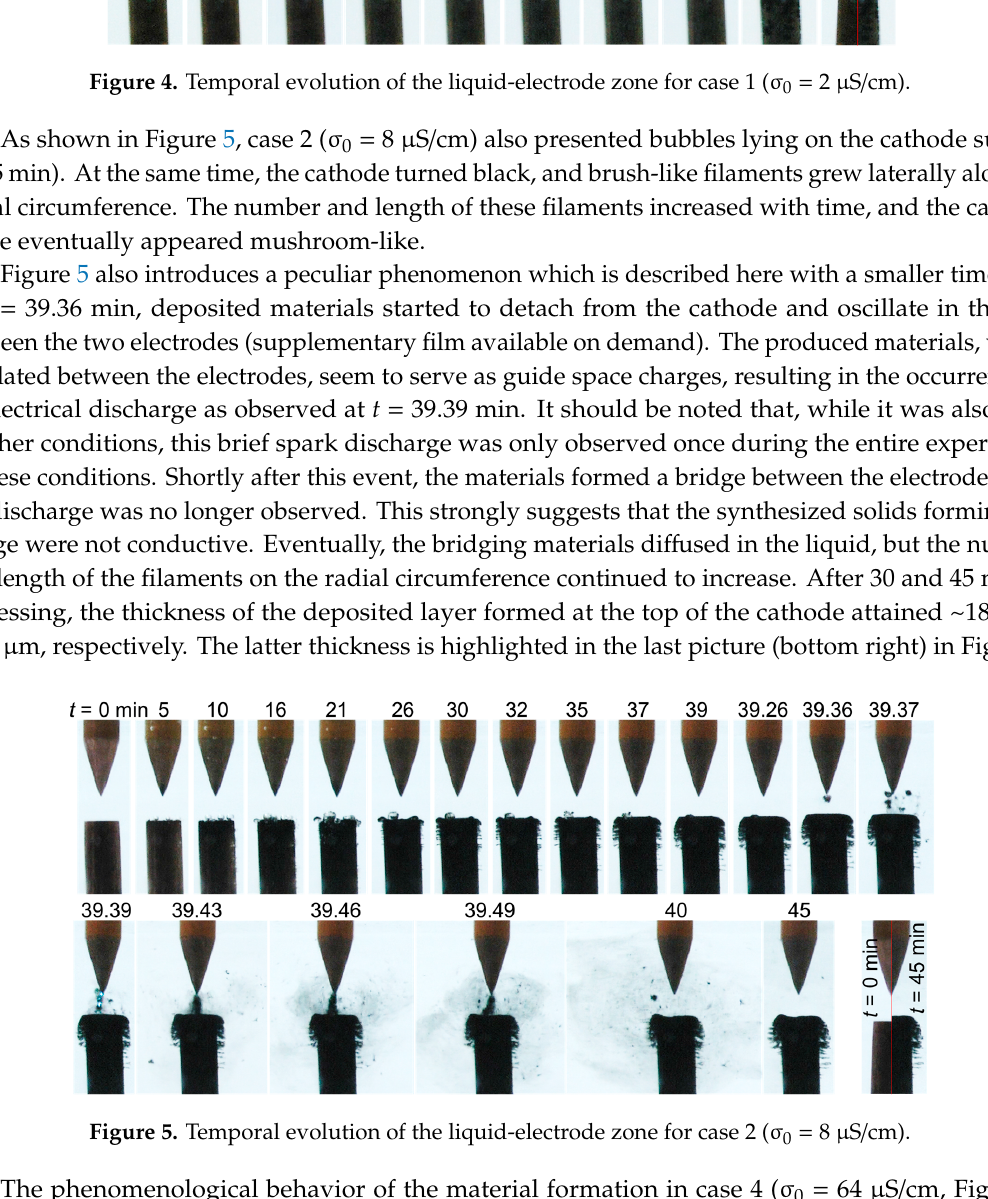
Figure 6. Temporal evolution of the liquid-electrode zone for case 4 ( σ 0 = 64 µS/cm). It is worth noting that once the high voltage was switched off, significant amounts of the materials, previously collected at the cathode, were ejected and slowly diffused within the solution towards the bottom of the chamber. Such ejection implies that the synthesized materials were electrostatically bound to the cathode (Figure 7).